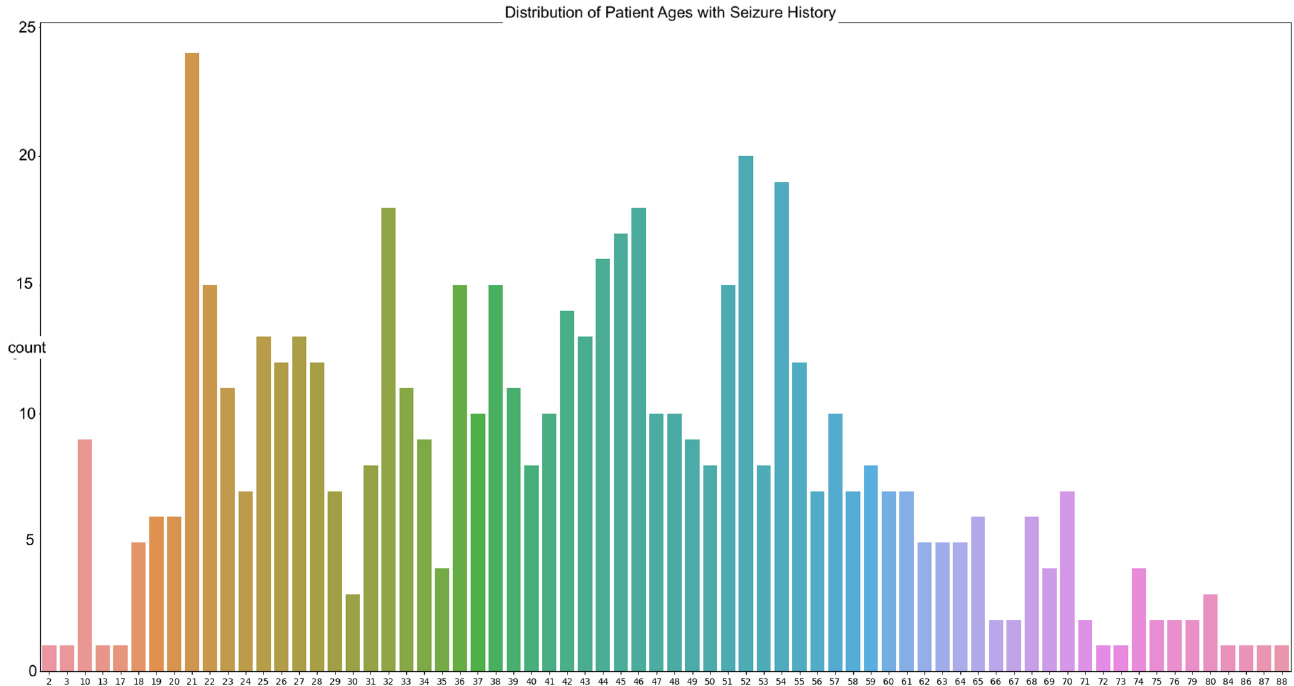
Figure 1. The distribution of patient ages from the utilized TUAB Corpus.